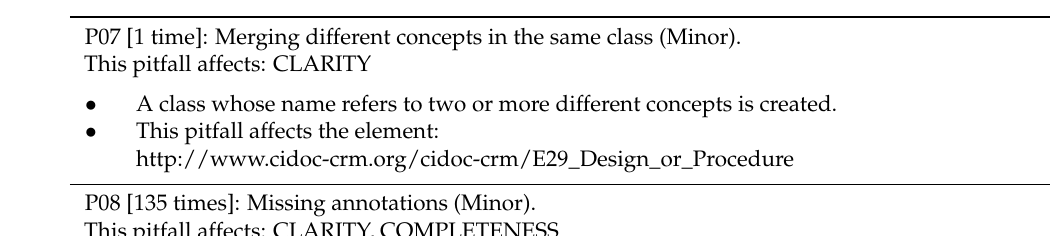
Table 6. Ontology pitfalls for the CIDOC